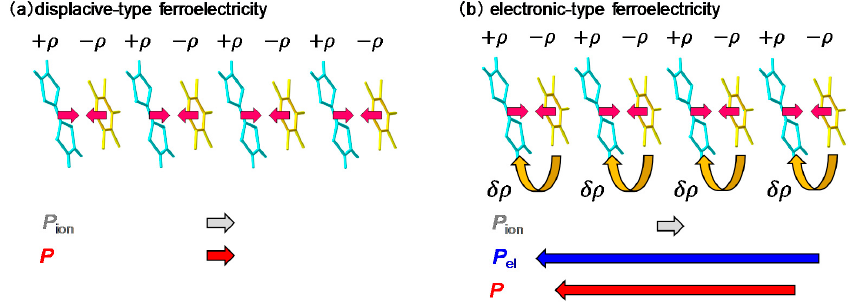
Figure 6. ( a , b ) Direction of ferroelectric polarization in the case of ( a ) displacive-type ferroelectricity and ( b ) electronic-type ferroelectricity. P ion and P el are polarizations originating from molecular displacements and from fractional intermolecular charge transfers, respectively. P is a net polarization ( P = P ion + P el